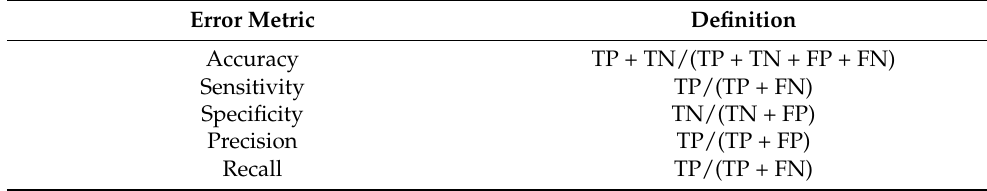
Table 6. Evaluation metrics.